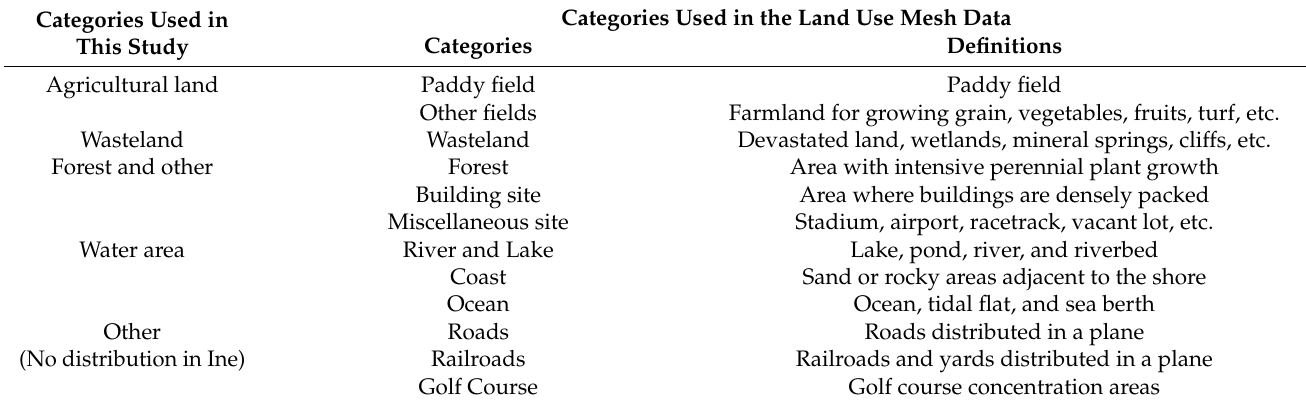
Table 3. Categories of land use mesh data